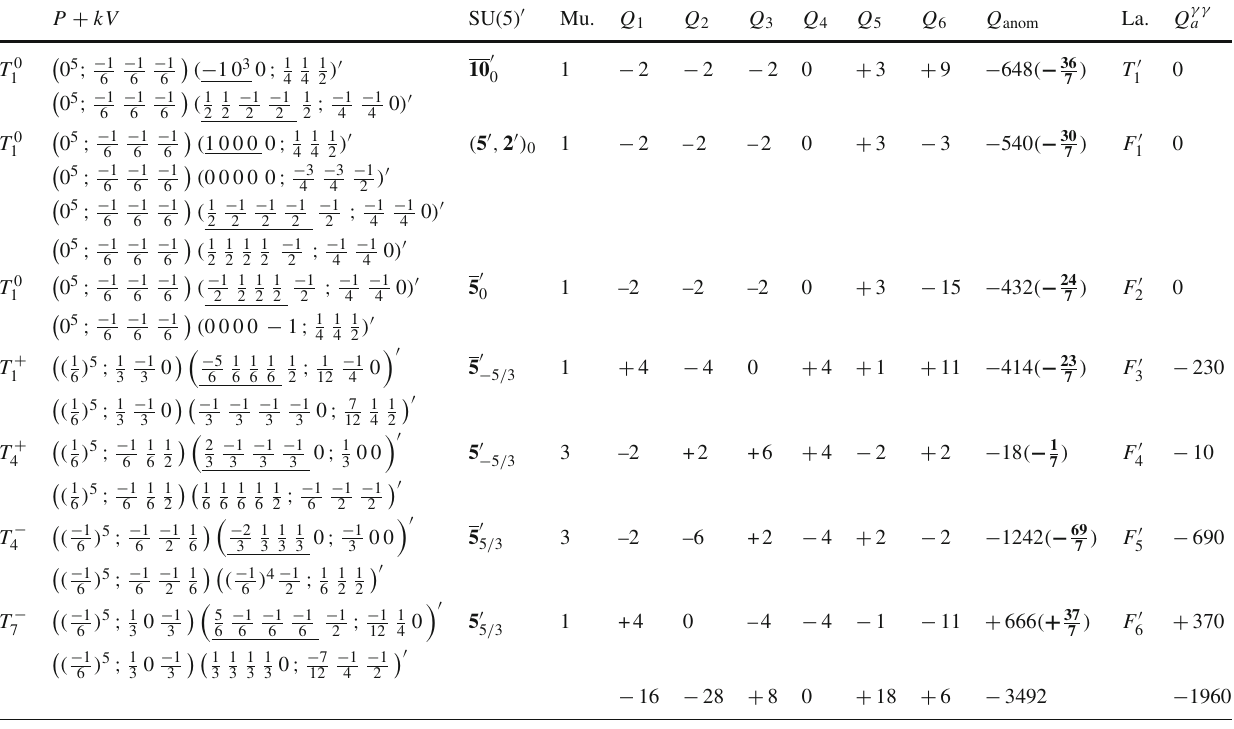
Table 5 The SU(5) (cid:2) representations. Notations are the same as in Table